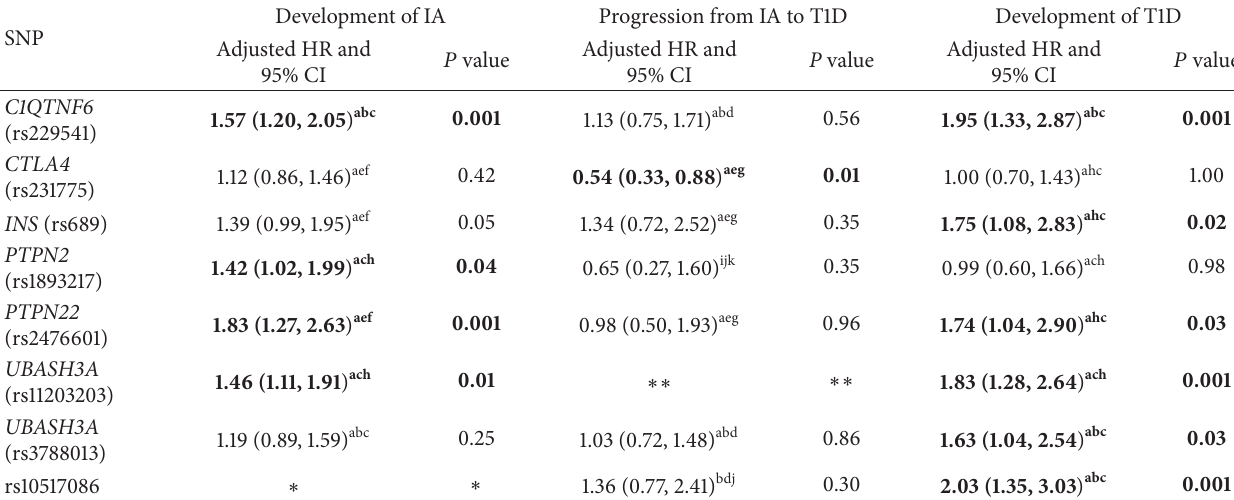
Table 3: Non-HLA T1D candidate SNPs associated with development of IA, progression from IA to T1D, and/or development of T1D in